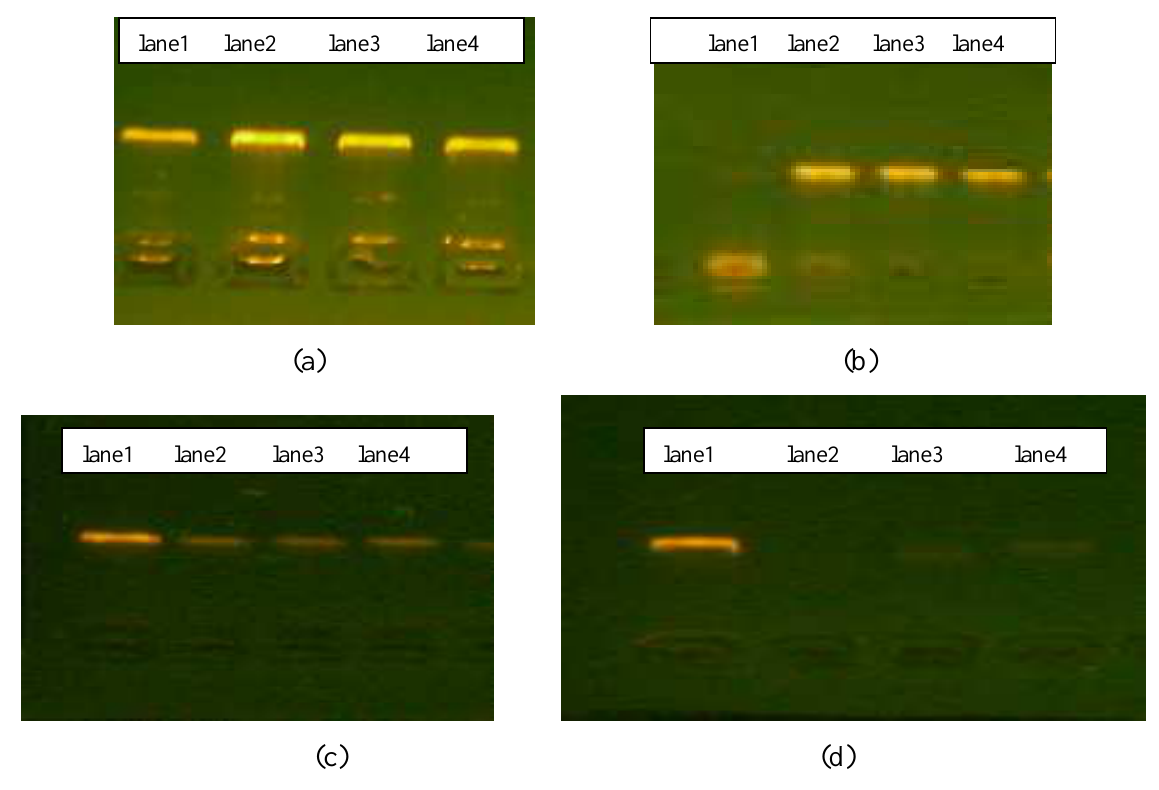
Figure 1. (a) Interaction between [Zn(H 0) ](p-HO-C H COO) ·2H 0 and genomic DNA in TAE 2 6 6 4 2 2 buffer at pH 7.4 in air, and incubating for 3 h. Lane 4: untreated genomic DNA (100 ng); lanes 1-3: 0) ](p-HO-C H COO) ·2H 0 with 0.1, 1, and 10mM, respectively. (b) Interaction DNA + [Zn(H 2 6 6 4 2 2 between [Zn (H 0) ] (p-HO-C H COO) . 2H 0 and genomic DNA in presence of ascorbate in TAE 2 6 6 4 2 2 buffer at pH 7.4 in air, and incubating for 3 h. Lane 4: untreated genomic DNA (100 ng); lanes 1-3: DNA + [Zn(H 0) ](p HOC H COO) ·2H 0 with 0.1, 1, and10mM, respectively. (c) Interaction 2 6 6 4 2 2 between [Zn(H 0) ](p-HOC H COO) ·2H 0 and genomic DNA in TAE buffer at pH 7.4 in air, and 2 6 6 4 2 2 incubating for 12 h. Lane 1: untreated genomic DNA (100 ng); lanes 2-4: DNA + [Zn(H C H COO) ·2H 0 with 0.1, 1, and 10mM, respectively. (d) Interaction between [Zn(H 6 4 2 2 C H COO) ·2H 0 and genomic DNA in presence of ascorbate in TAE buffer at pH 7.4 in air, and 6 4 2 2 incubating for 12 h. Lane 1: untreated genomic DNA (100 ng); lanes 2-4: DNA + [Zn(H C H COO) ·2H 0 with 0.1, 1, and10mM, 6 4 2 2